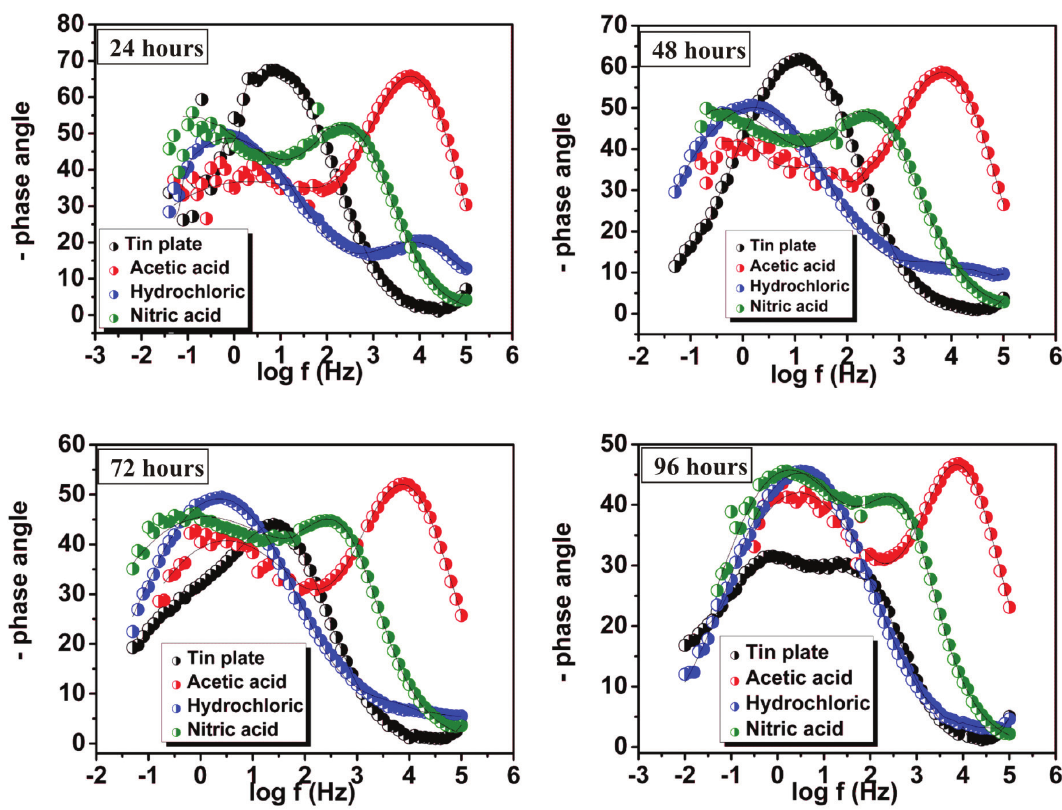
Figure 8. Bode 1 diagrams for different immersion time in a NaCl 0.05M